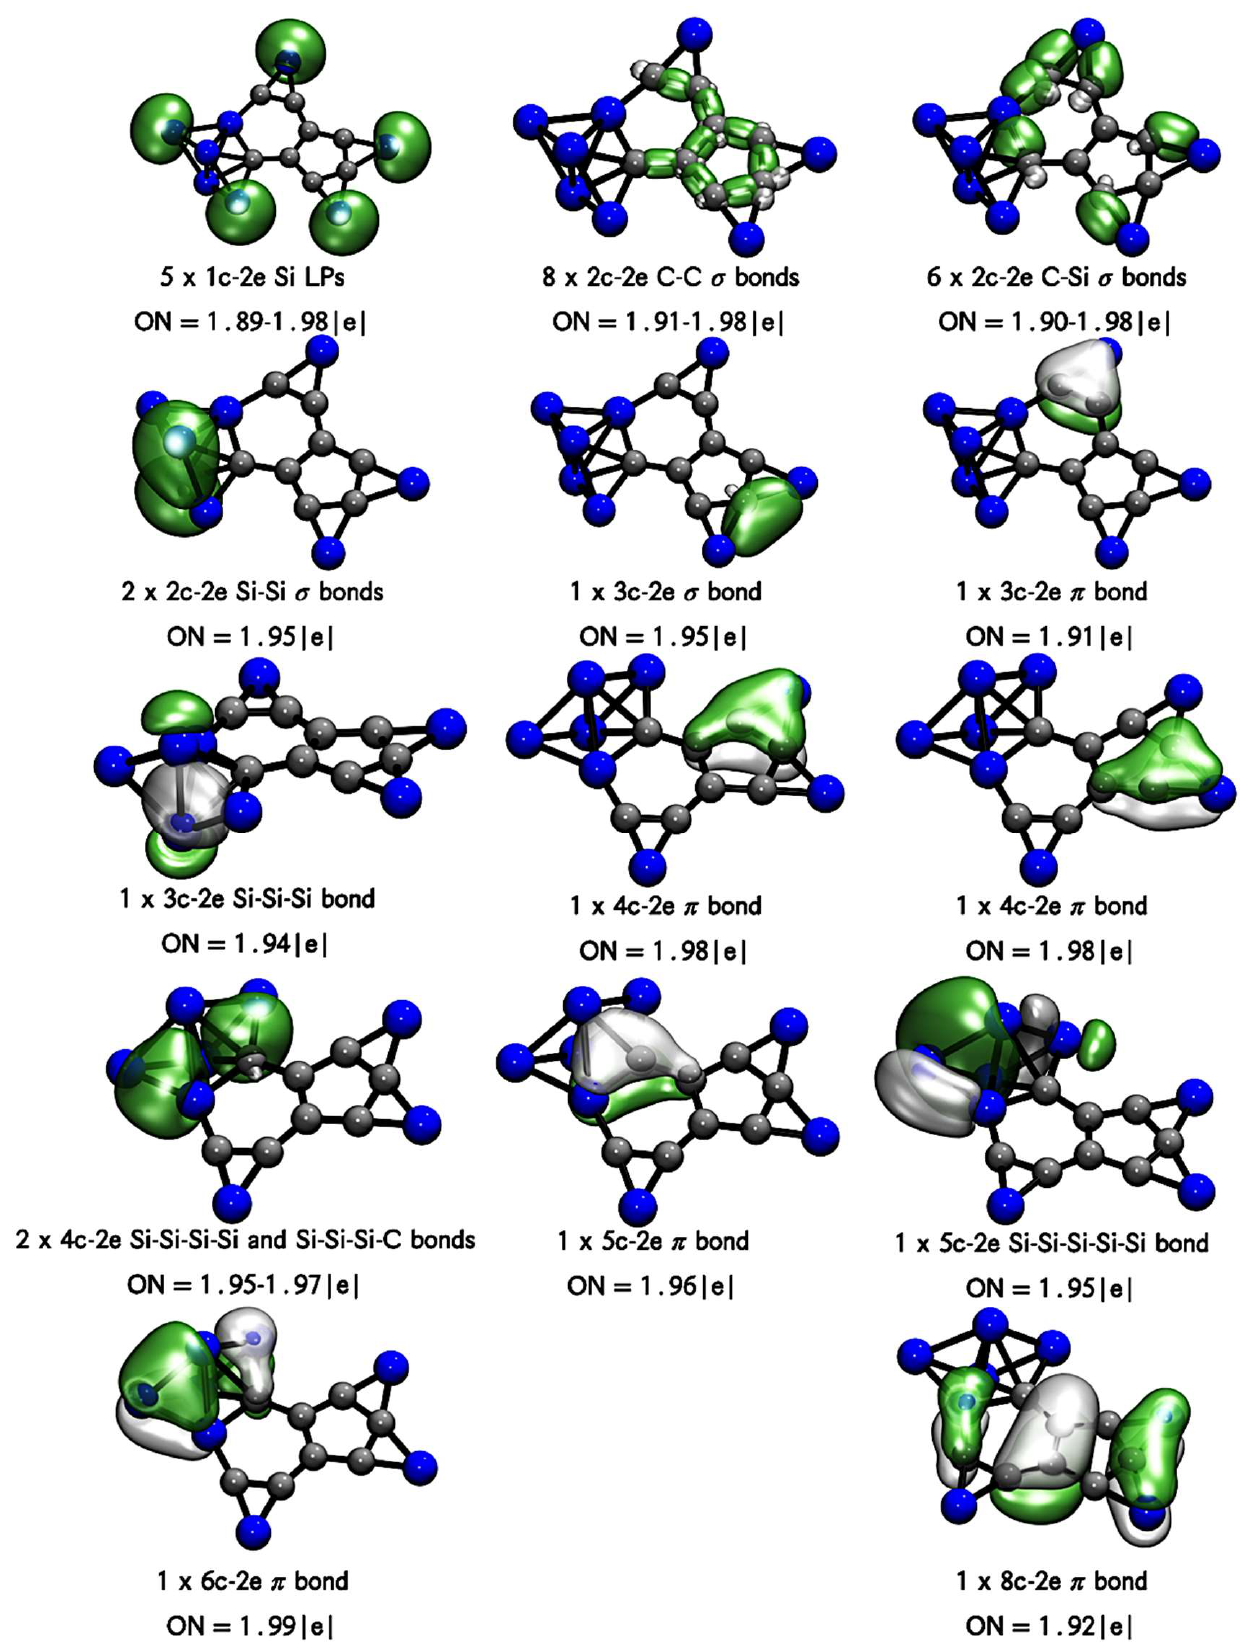
Figure 4. AdNDP bonding pattern of cluster Si 8 C 8 . Occupation numbers (ONs) are shown.